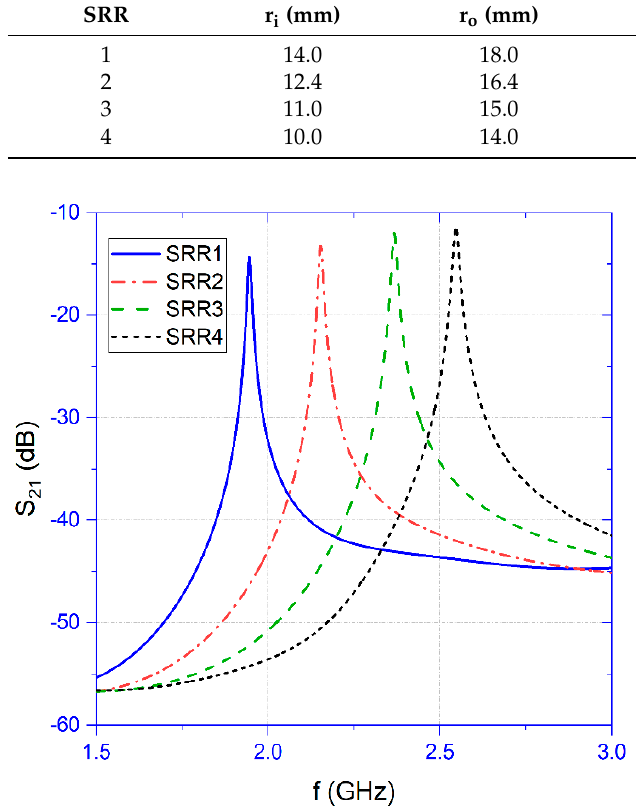
Figure 2. Transmission coefficients of split ring resonators in air. Table 1. Geometric dimensions of Split Ring Resonators.